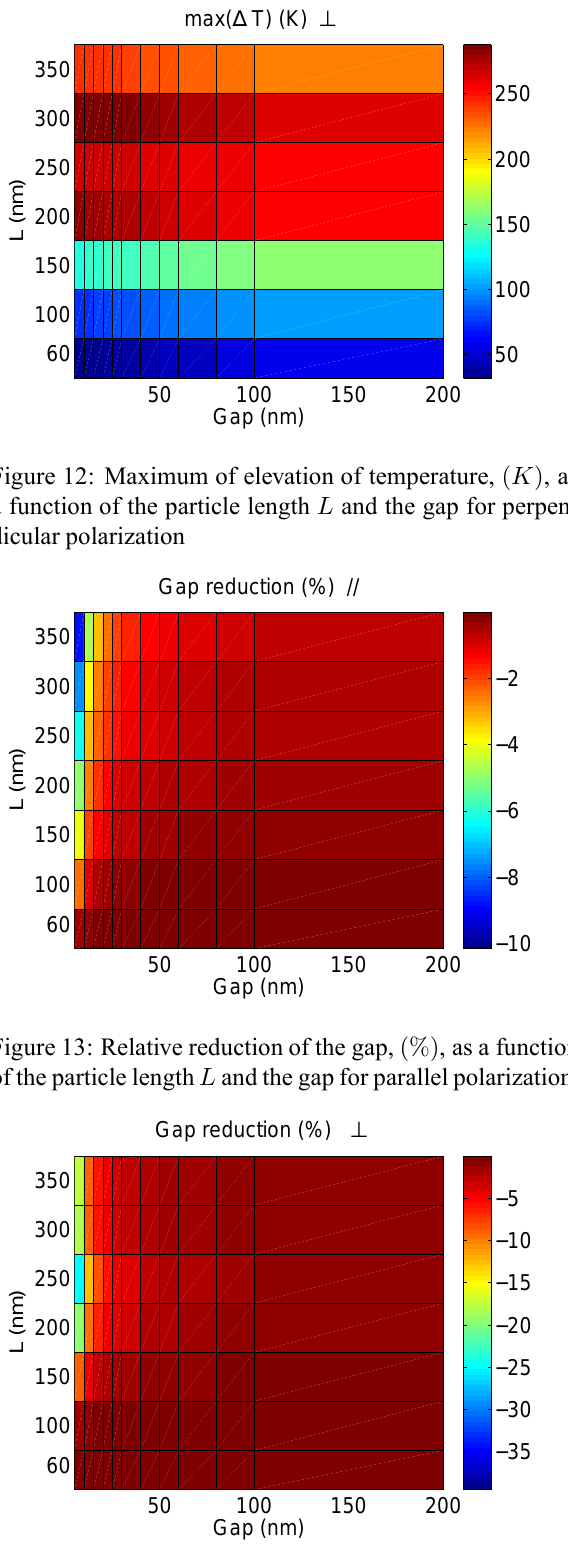
Figure 14: Relative reduction of the gap, (%) , as a func- tion of the particle length L and the gap for perpendicular polarization